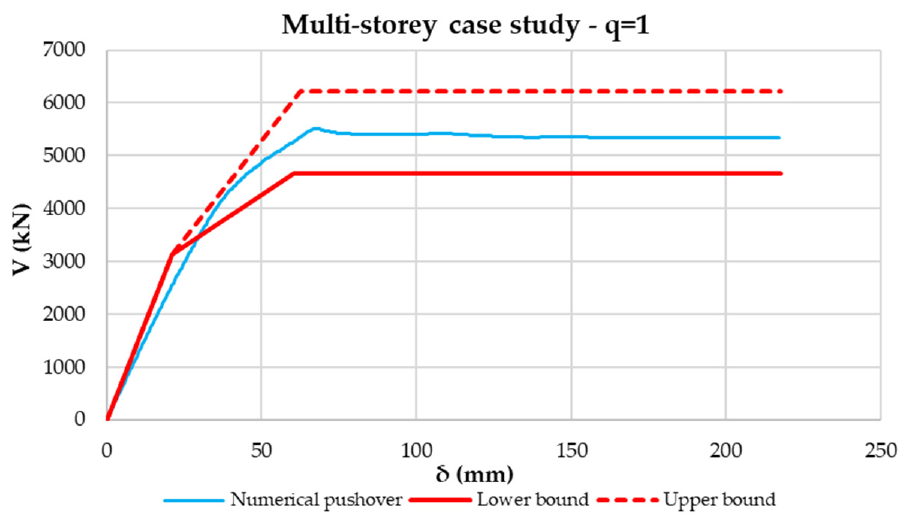
Figure 24. Comparison between numerical pushover curve and analytical spindle for the multi-storey building case study with structure factor equal to 1.